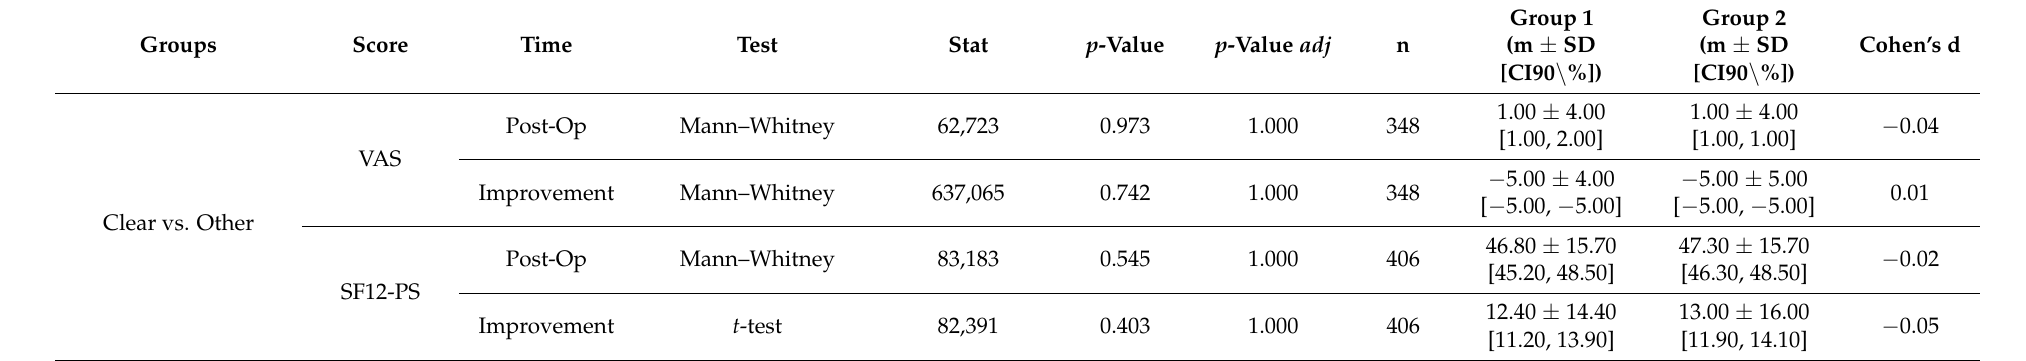
Table 5. Full results for the hypothesis tests (6-month